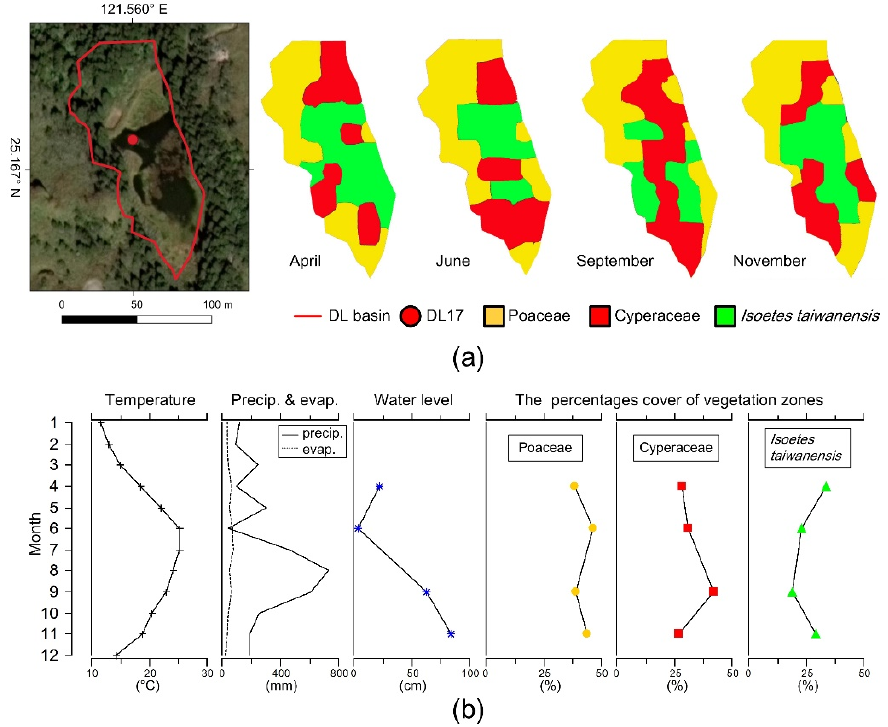
Figure 2. ( a ) Satellite photograph of coring site (red circle) and the spatiotemporal distribution of wetland vegetation in the Dream Lake (DL) basin in 2013. ( b ) Mean monthly temperature, precipitation, evaporation, water level, and percentage cover of three vegetation types in DL in 2013